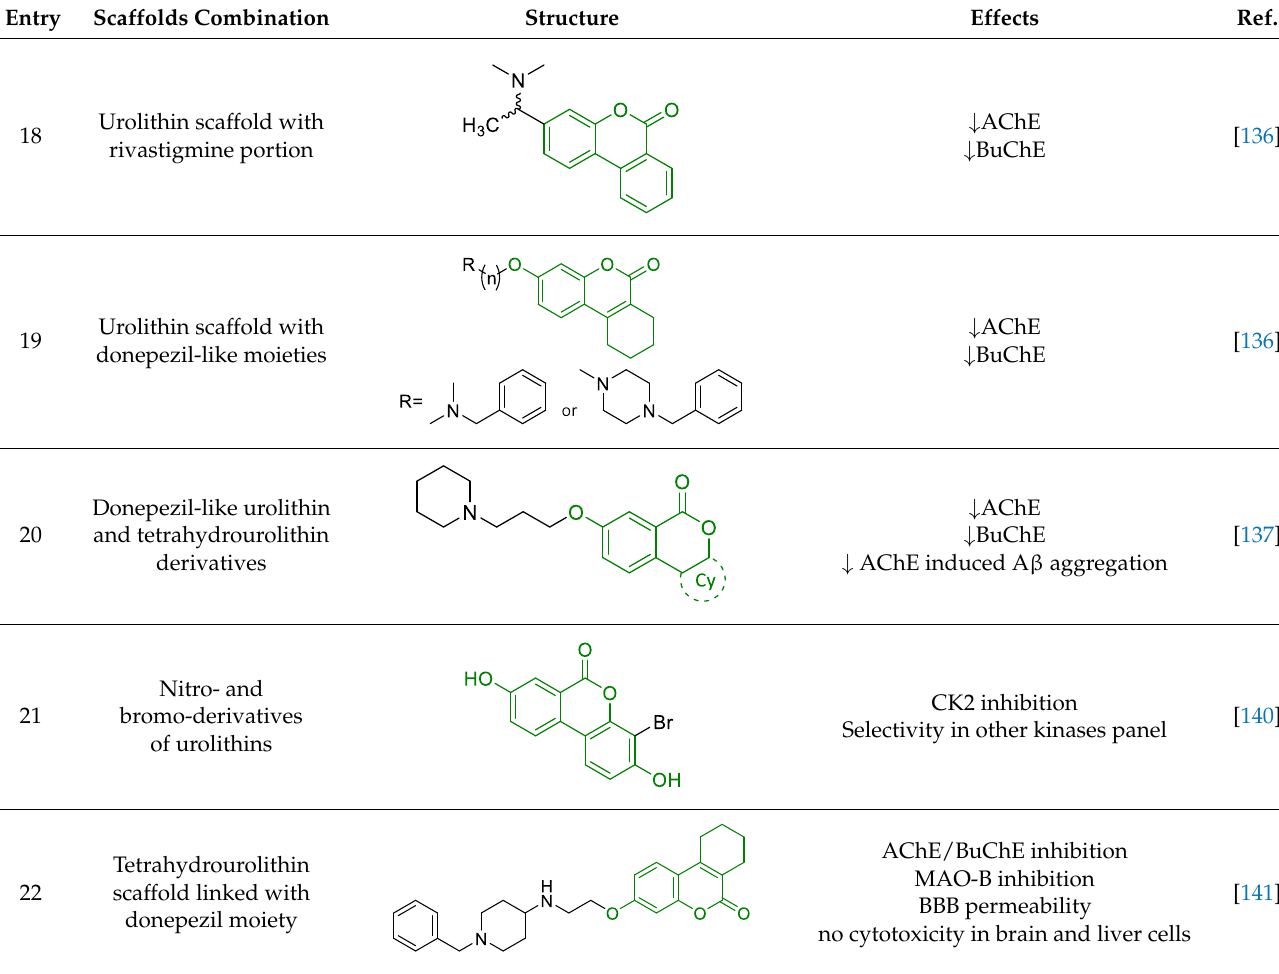
Table 4. Urolithins derivatives and their main biological effects.